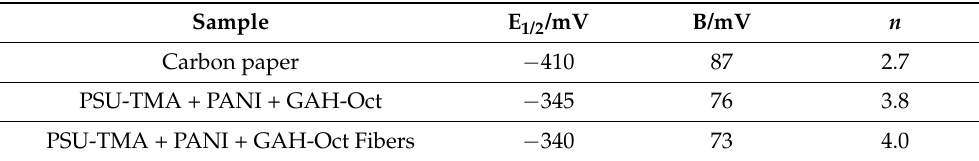
Table 2. Electrochemical properties of ORR electrodes: half-wave potential E 1/2 , Tafel slope B, number of exchanged electrons n (see text) at E = − 0.5 V vs.